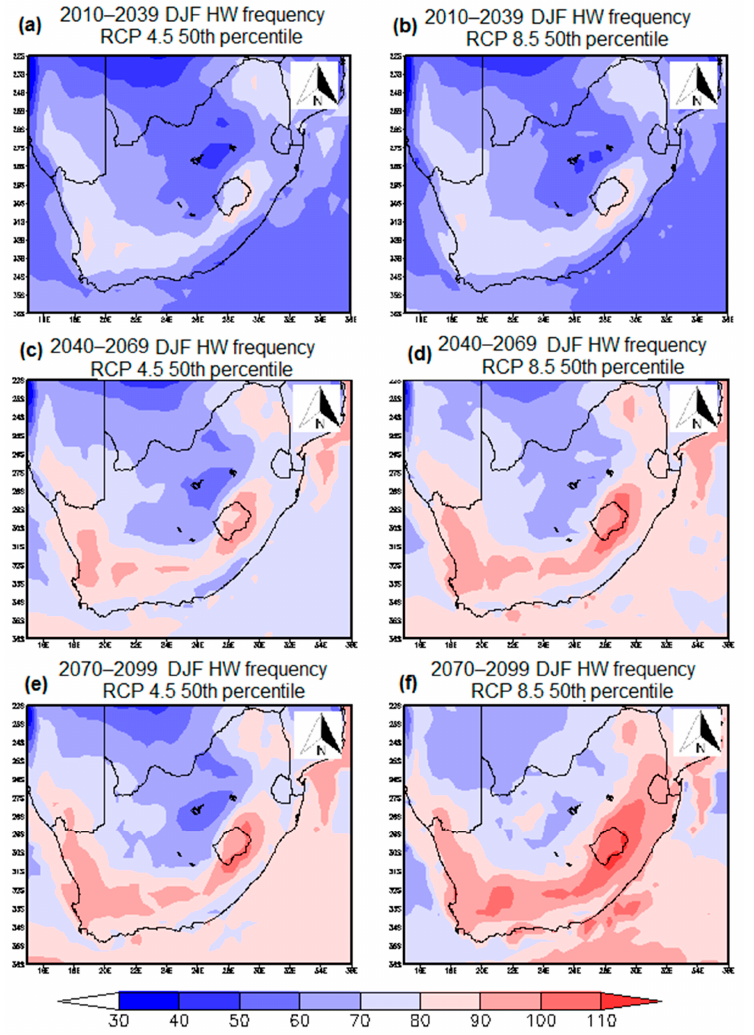
Figure 7. Simulations of DJF HW frequency (total number of occurrence) 50th percentile for ( a ) 2010–2039 RCP 4.5, ( b ) 2010–2039 RCP 8.5, ( c ) 2040-2069 RCP 4.5, ( d ) 2040–2069 RCP 8.5, ( e ) 2070-2099 RCP 4.5 and ( f ) 2070–2099 RCP